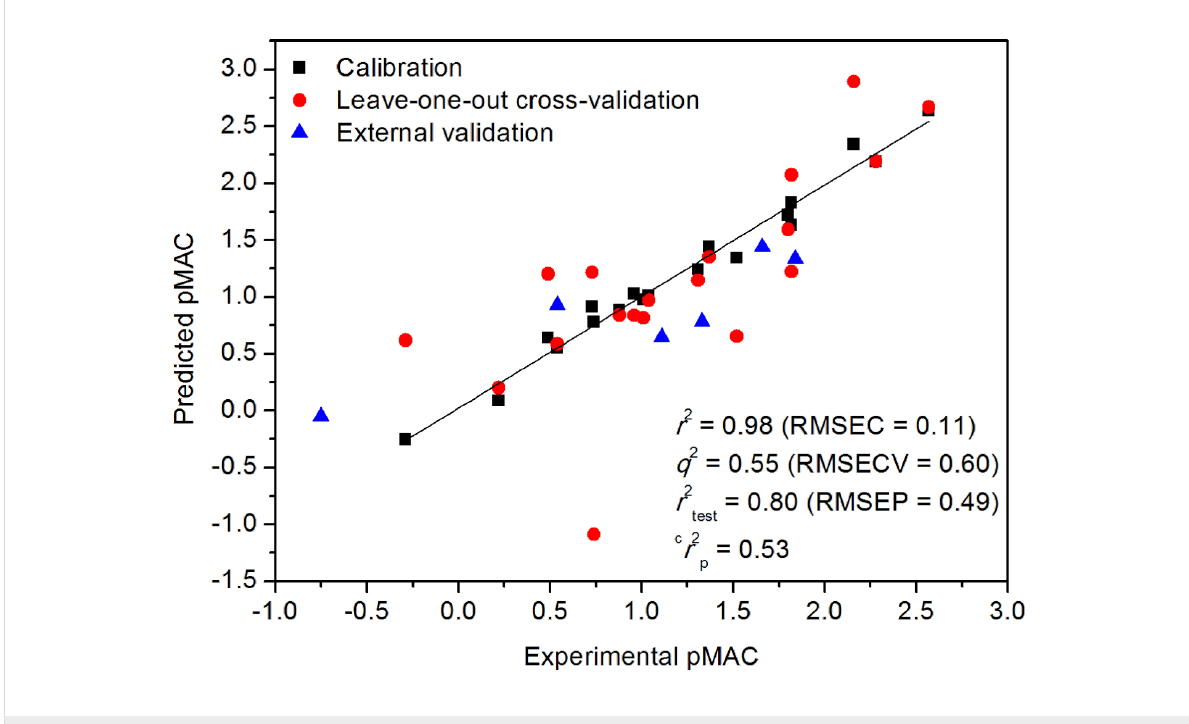
Figure 3: Plot of actual vs predicted pMAC obtained from the MIA-QSAR